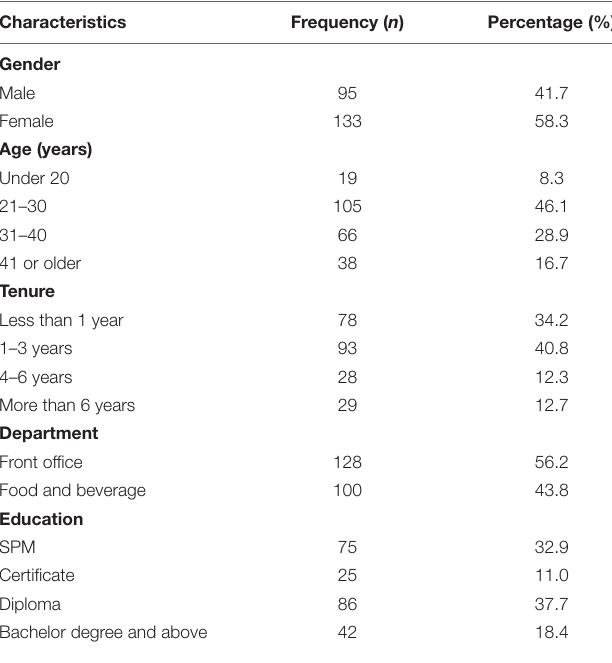
TABLE 1 | Profile of the respondents ( n =